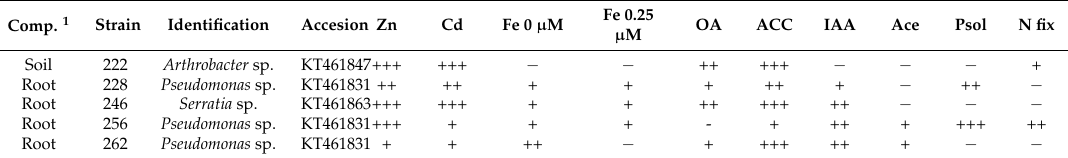
Fe 0.25 µ M OA ACC IAA Ace Psol N fix